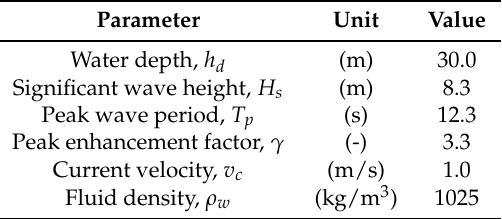
Table 8. Sea state characteristics investigated in the case study.